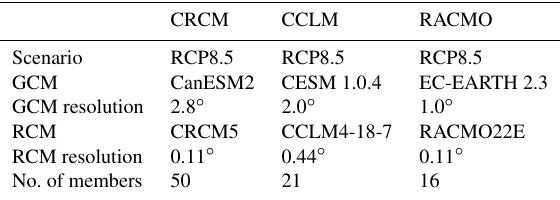
Table 2. Specifications of the three ensembles used in this